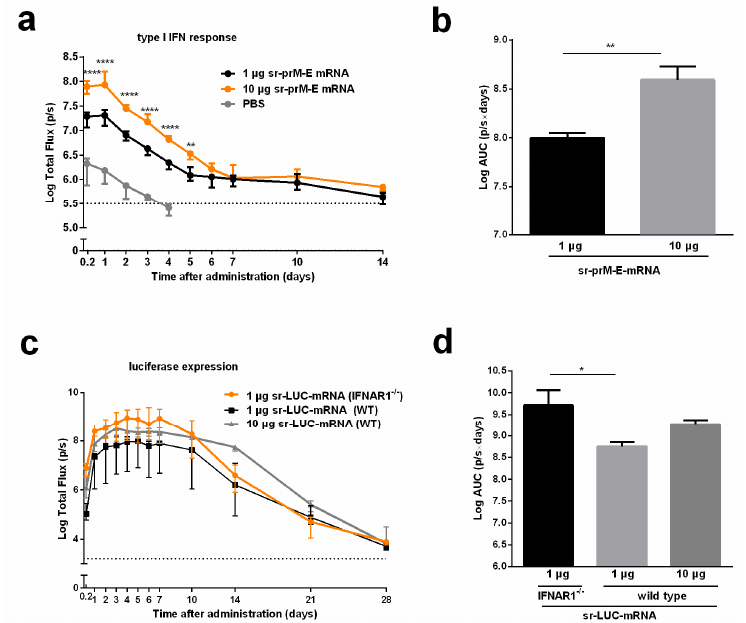
Figure 4. Interferon response after intradermal electroporation of the sr-prM-E mRNA ZIKV vaccine and e ff ect of IFNAR1 on the expression of sr-LUC-mRNA. ( a ) IFN- β luciferase reporter (IFN- β +/ ∆ β -luc ) mice were intradermally electroporated with 1 or 10 µ g of sr-prM-E-mRNA ZIKV vaccine and the type I interferon response was monitored by measuring the bioluminescent signal at the injection spot for 14 days. The AUC of the curves in (a) are shown in ( b ) ( n = 3). ( c ) C57BL / 6 WT and IFNAR1 - / - mice were intradermally electroporated with 1 or 10 µ g sr-LUC-mRNA and the luciferase expression was determined by measuring the bioluminescent signal at the injection spot for 28 days. The results of the statistical analysis of the data shown in ( c ) can be found Table S2. The AUC of the curves in (c) are shown in ( d ) ( n = 4). Data are represented as median with interquartile range and statistical analysis was performed using ANOVA followed by Tukey’s test.